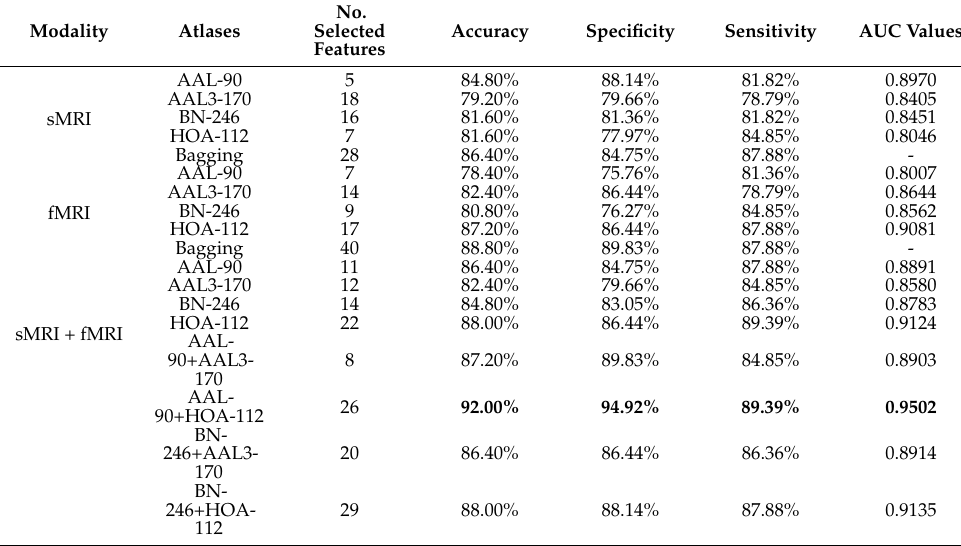
Table 2. The MCI classification performance in different